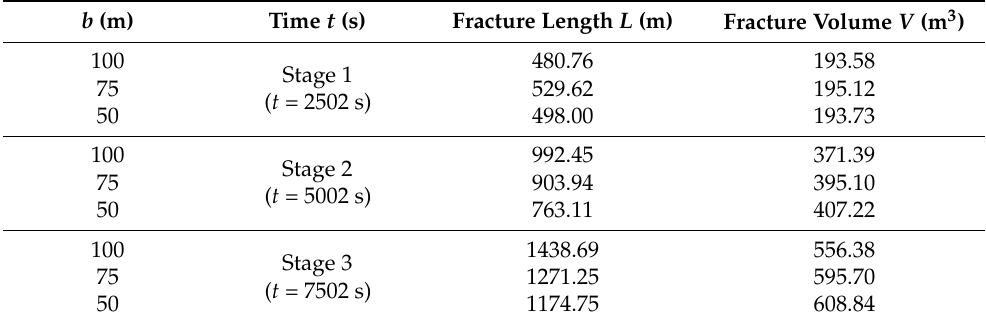
Figure 14. Volume evolution of hydraulic fracture for different stages and well spacings. Table 3. Fracture length and volume of fracture network for different stages and well